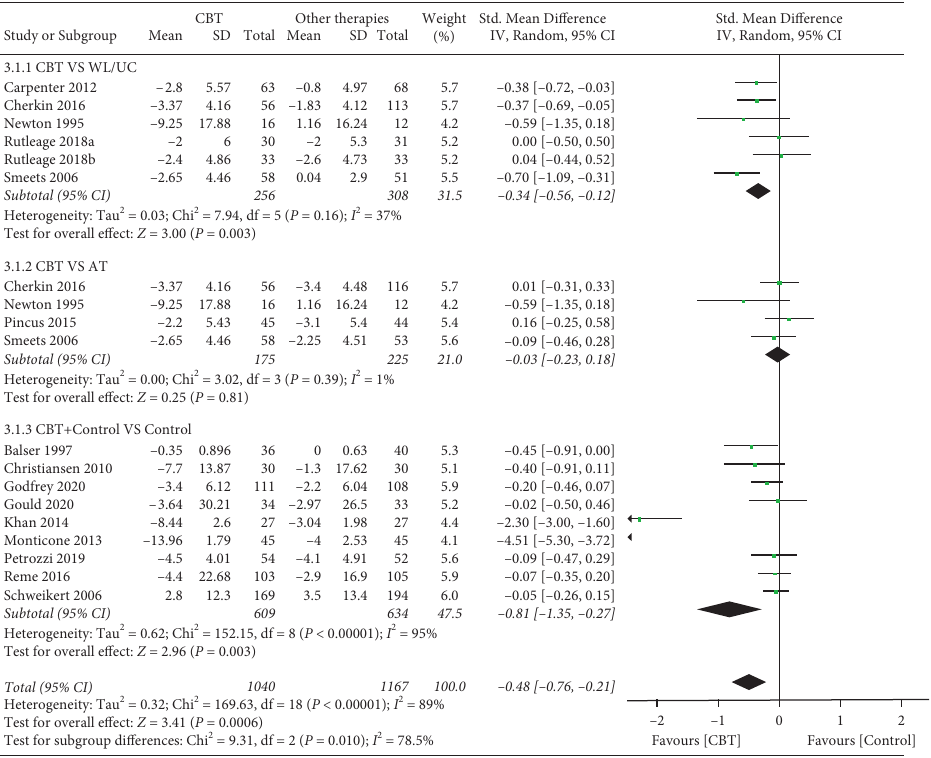
Figure 7: The outcome of disability of different control subgroups. Compared with the waiting list or usual care, the overall effect of CBTon improving disability showed statistical significance ( P < 0 . 05). Combining CBT with other therapies showed a greater overall effect than other therapies alone ( P < 0 .